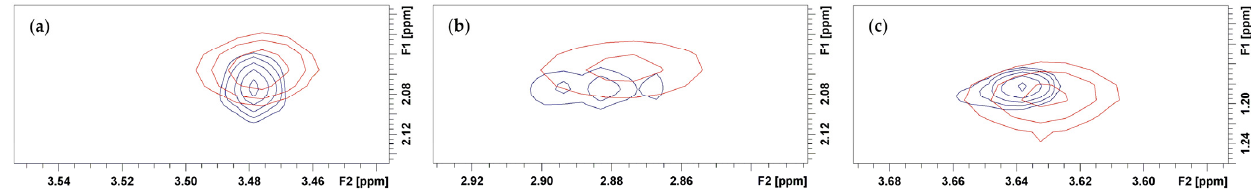
Figure 4. Free (blue) and bound-state (red) NOE cross peaks indicative of the folded-out conformation: ( a ) H4-H11; ( b ) H2-H4; and ( c ) H5-H6Me.